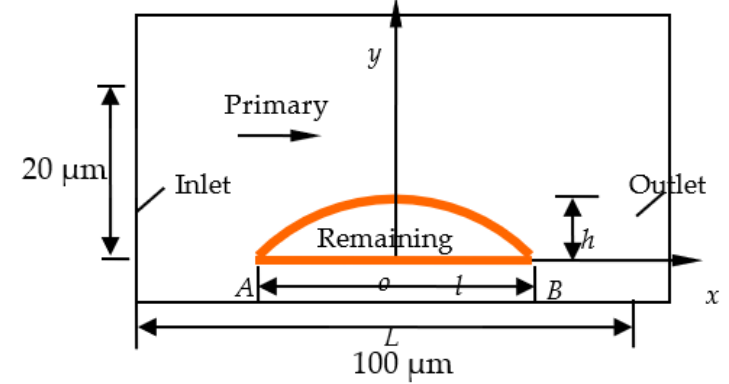
Figure 1. Calculation area diagram.